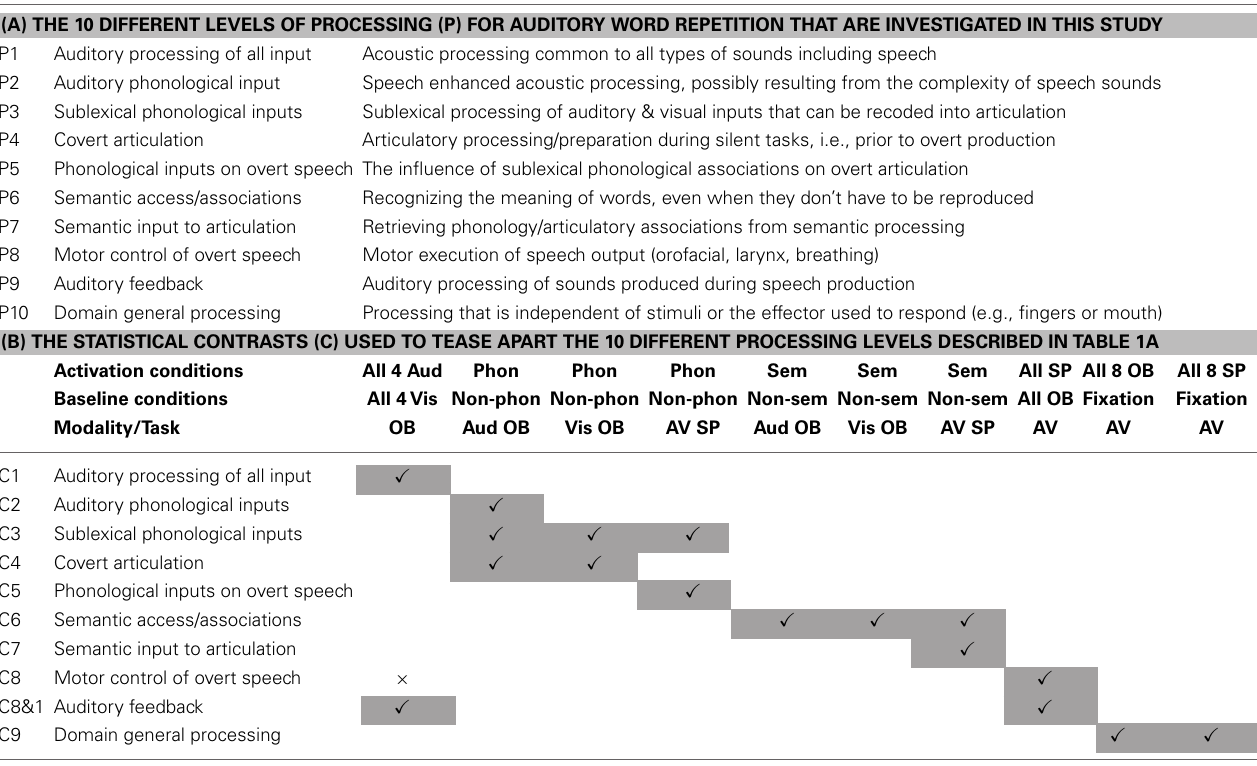
Table 1 | (A) Task decomposition for auditory word repetition into 10 processing functions of interest (P1–P10); (B) The 10 statistical contrasts (C1–C9, with two variants of C8) used to identify regional responses to each of the 10 processing functions of interest in (A). (A) THE 10 DIFFERENT LEVELS OF PROCESSING (P) FOR AUDITORY WORD REPETITION THAT ARE INVESTIGATED IN THIS